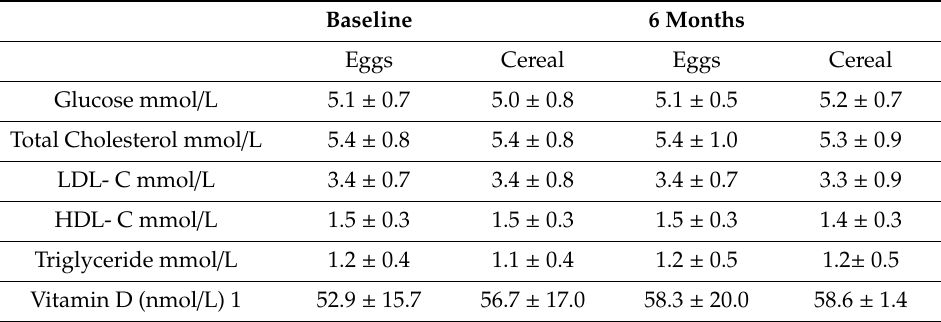
Table 3. Glucose and lipid concentrations 1 .